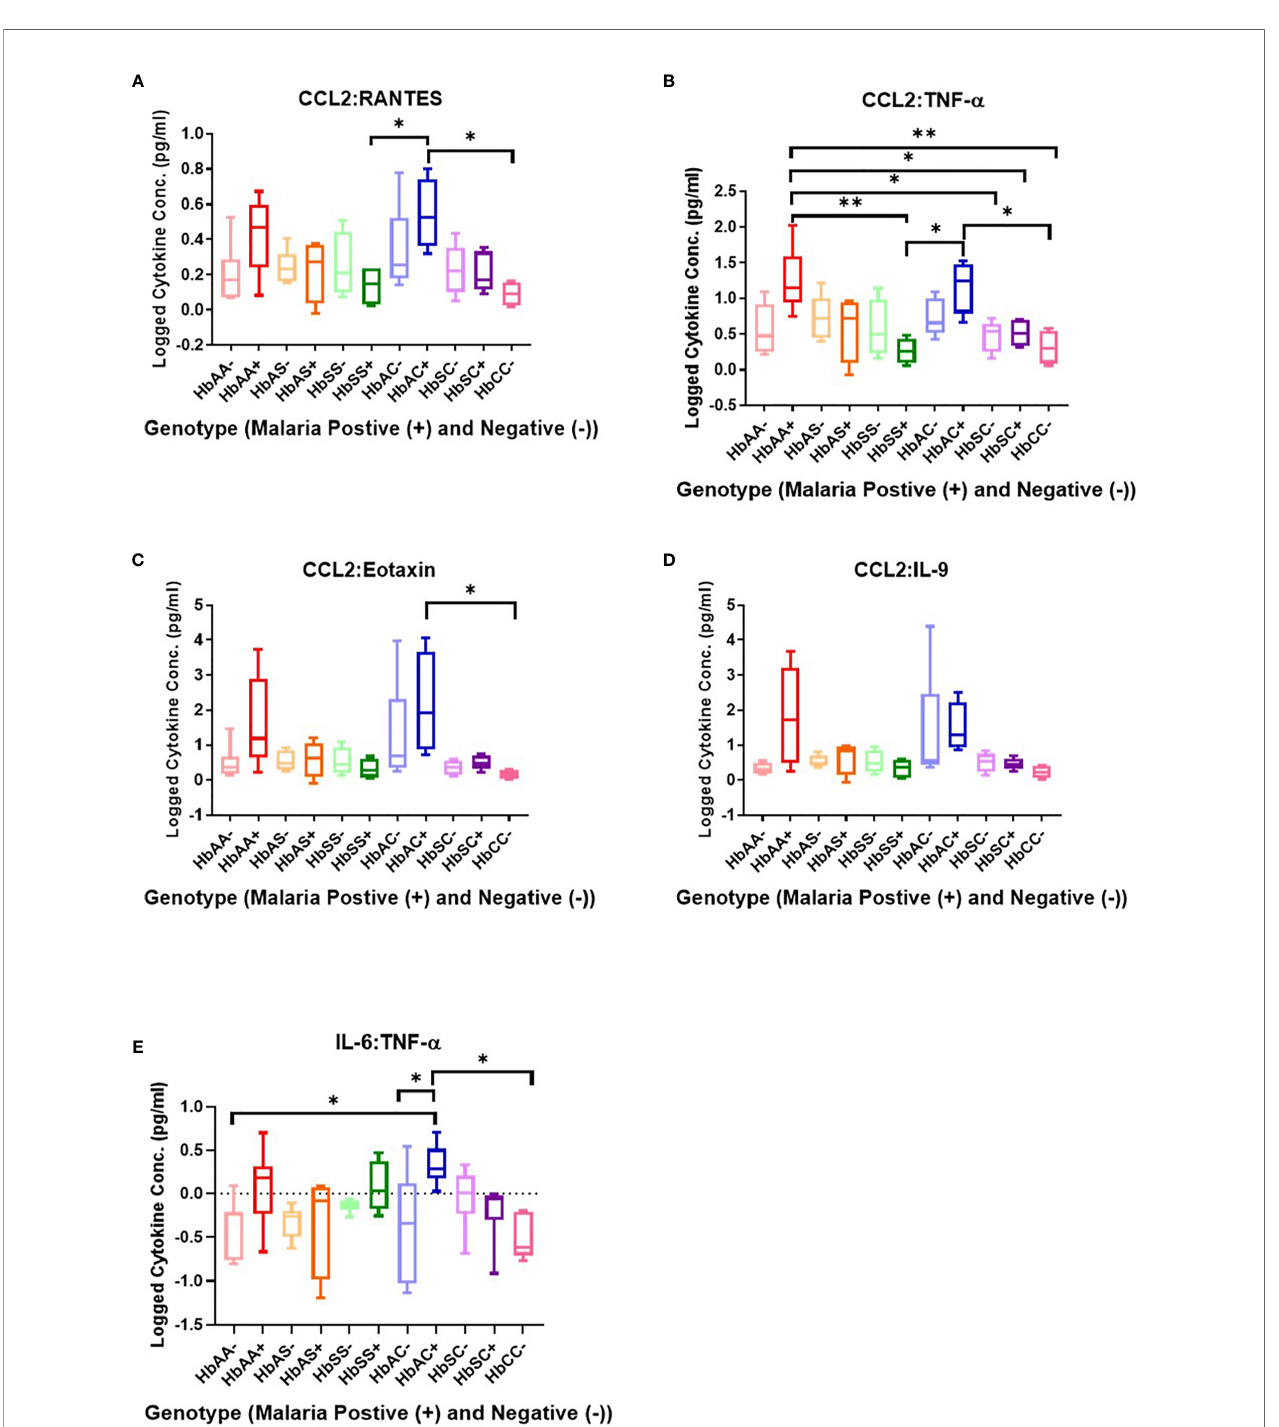
FIGURE 4 | Assessment of cytokine concentration ratios in all Hb genotypes with (+) and without (-) malaria. A one-way ANOVA and Tukey ’ s multiple comparison test was used to assess between all the genotypes with (+) and without (-) malaria. (A) CCL2:RANTES HbSS+ (µ = 0.13) vs HbAC+ ( m = 0.54, P = 0.049) and HbAC+ ( m = 0.54) vs HbCC- ( m = 0.09, P = 0.02). (B) CCL2:TNF- a HbAA+ ( m = 1.24) vs HbSS+ (µ = 0.26, P = 0.003), HbAA+ (µ = 1.24) vs HbSC- ( m = 0.46, P = 0.02), HbAA+ ( m = 1.24) vs HbSC+ ( m = 0.51, P = 0.04), HbAA+ ( m = 1.24) vs HbCC- ( m = 0.31, P = 0.006), HbSS+ ( m = 0.26) vs HbAC+ ( m = 1.17, P = 0.01), R2 HbAC+ ( m = 1.17) vs HbCC- ( m = 0.31, P = 0.02). (C) CCL2:Eotaxin HbAC+ ( m = 2.16) vs HbCC- ( m = 0.17, P = 0.0498). (D) CCL2:IL-9 (= 0.35, P = 0.04) but there were no signi fi cant differences using the Tukey ’ s multiple comparison test. (E) IL-6:TNF- a HbAA- ( m = -0.4) vs HbAC+ ( m = 0.33, P = 0.03), HbAC- ( m = -0.38) vs HbAC+ ( m = 0.33, P = 0.049), and HbAC+ ( m = 0.33) vs HbCC- ( m = -0.49, P = 0.02). *: 0.049-0.01, **: